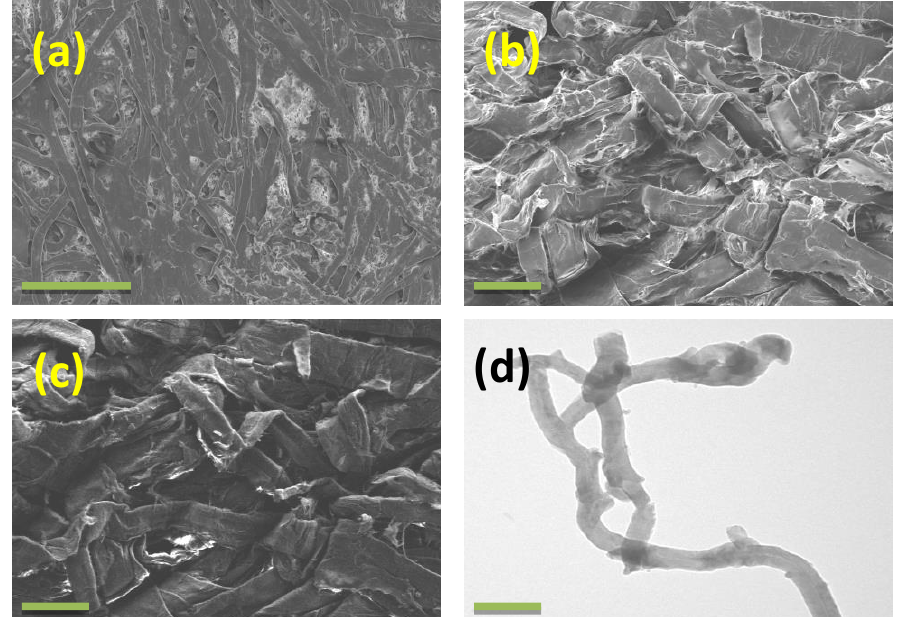
Figure 1. Scanning electron microscopy (SEM) micrographs of waste paper ( a ) and microfibrillated cellulose ( b ) extracted using NaOH / urethane aqueous system and corresponding secondary electron image ( c ), and representative transmission electron microscopy (TEM) image ( d ). Scale bars are 20 µ m in ( a ), 2 µ m in ( b , c ), and 1 µ m in ( d) .